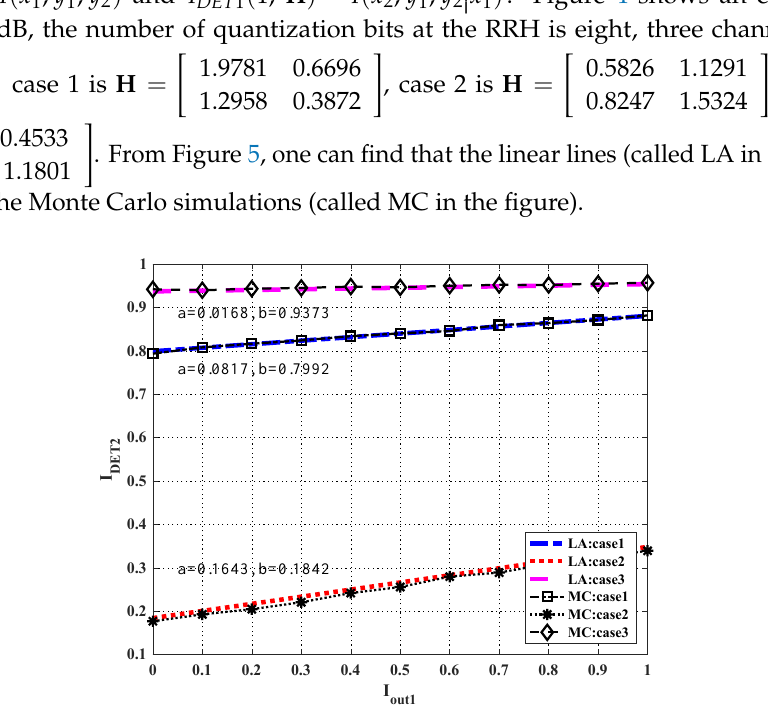
Figure 5. Extrinsic information transfer (EXIT) chart for the multi-user (MU) detector .